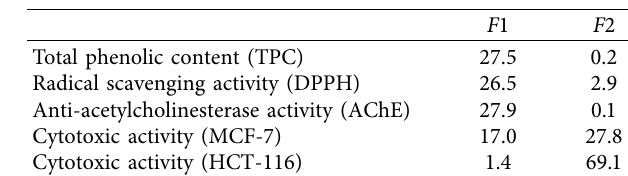
Table 6: Contribution of variable factors to the principal com- ponent’s analysis (%).